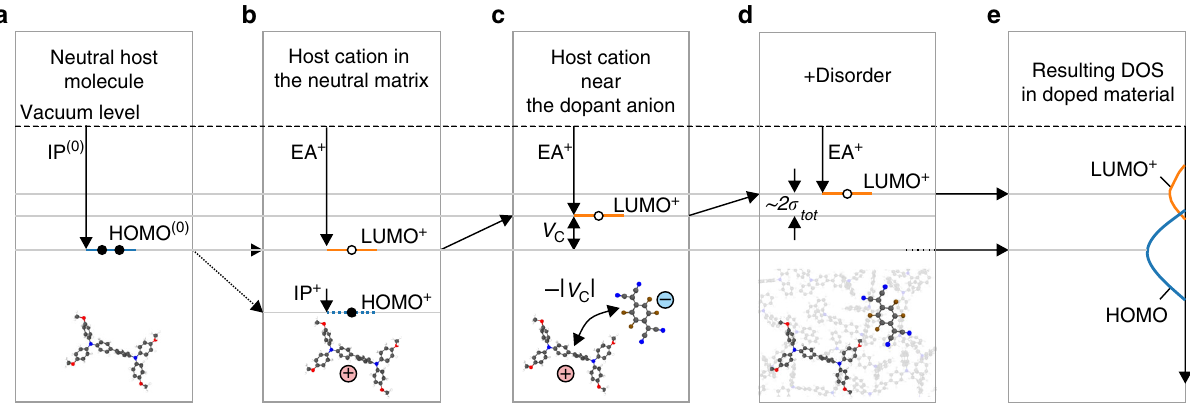
Fig. 1 Computed density of states (DOS) in doped organic semiconductors. a DOS of doped organic semiconductors with zero intrinsic disorder on a logarithmic scale for three dopant molar ratios (DMR) (DMR = {10 − 3 , 10 − 2 , 1.5 × 10 − 1 }). Relevant part of the DOS comprises energy distributions of the highest occupied and lowest unoccupied host orbitals, HOMO and LUMO + , respectively. HOMO (0) and | V C | is the mean HOMO of the corresponding undoped material, and the Coulomb interaction energy between the host cation and dopant anion at a distance a with a being the lattice constant. Feature “ a ” ( “ b ” ) in the top panel corresponds to neutral host molecules at a distance of a to host cations (dopant anions) and a = cations). Features “ c ” and “ d ” correspond to host cations at distances of a = and middle panels), novel LUMO + distribution appears approximately at HOMO (0) + | V C |. b The same as a in a linear scale. Note the broadening of HOMO/LUMO + distributions upon doping. c The same as b for high ( σ int = 0.2 eV) intrinsic disorder. In this case the mean LUMO + is separated from HOMO (0) by the energy signi fi cantly larger than | V C | (cf. top panels of a and c ) due to intrinsic disorder. The Fermi level position (denoted by E F ) determined from the DOS is always the crossing point of HOMO and LUMO + distributions so that the density of states at E F is low. The LUMO + distribution in panels b and c has been multiplied by a factor of 100, 10, 1 from top to bottom to enhance visibility at low doping molar rates. The density of states in all panels is normalized so that the maximum DOS value is equal to 1